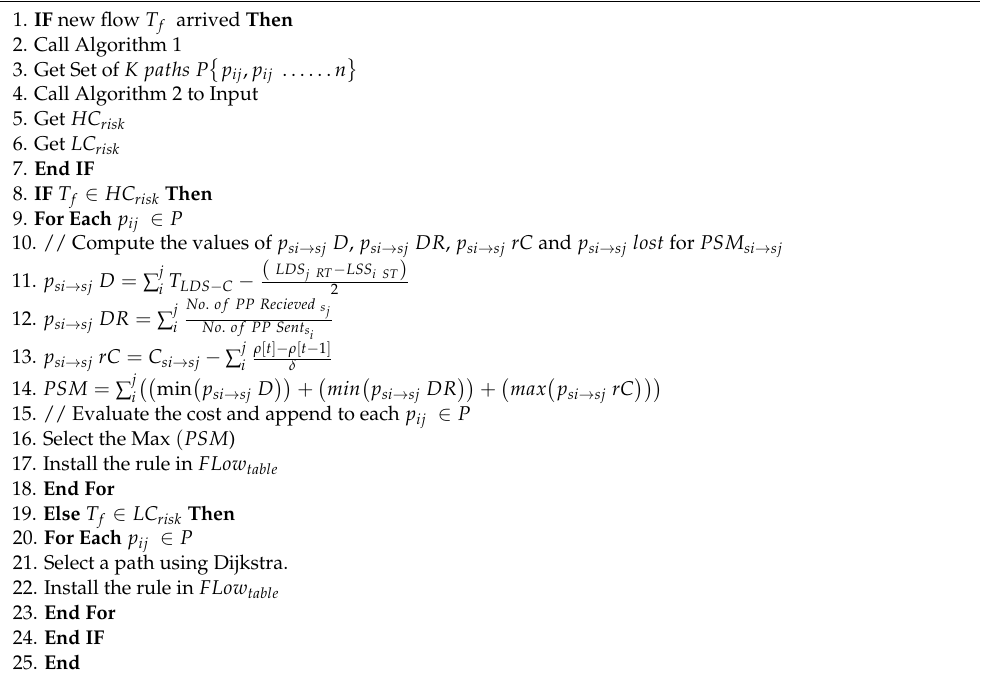
Algorithm 3 Adaptive Path Selection Algorithm with Flow Classification